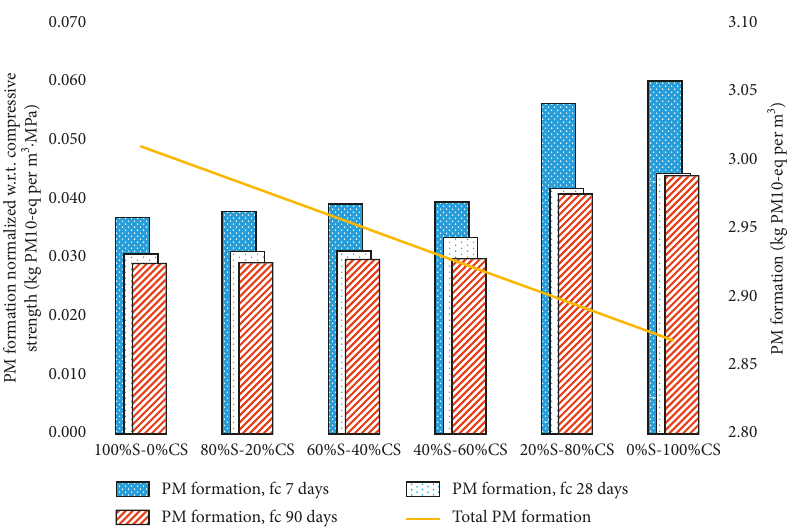
Figure 12: Normalized PM formation of concrete mixes with respect to their compressive strengths at varying curing ages, GreenConcrete LCA tool